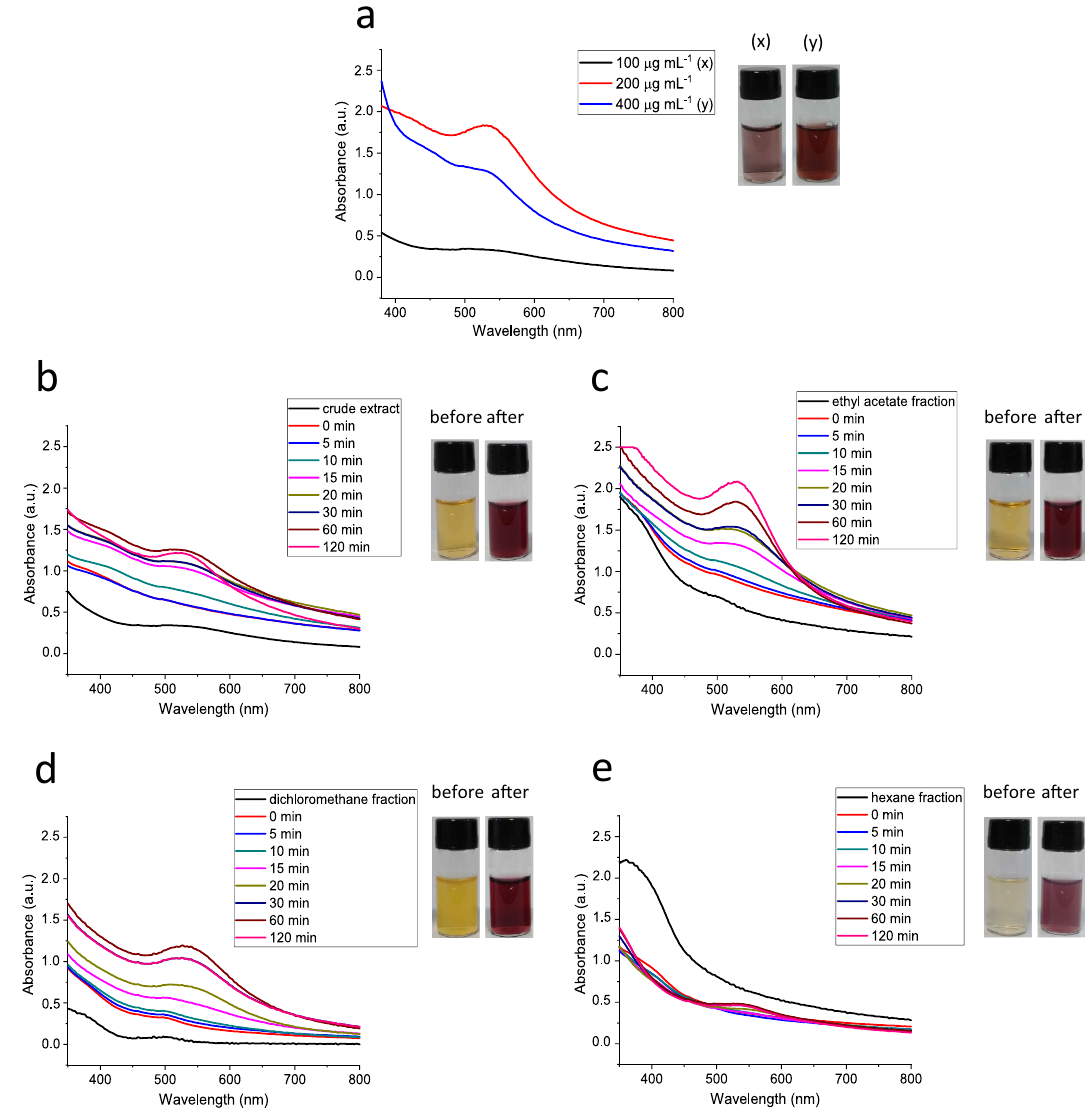
Figure 2. UV–vis spectra of biosynthesized gold nanoparticles: ( a ) using different BRP extract concentrations; ( b ) AuNP extract ; ( c ) AuNP ethyl acetate; ( d ) AuNP dichloromethane ; ( e ) AuNP hexane